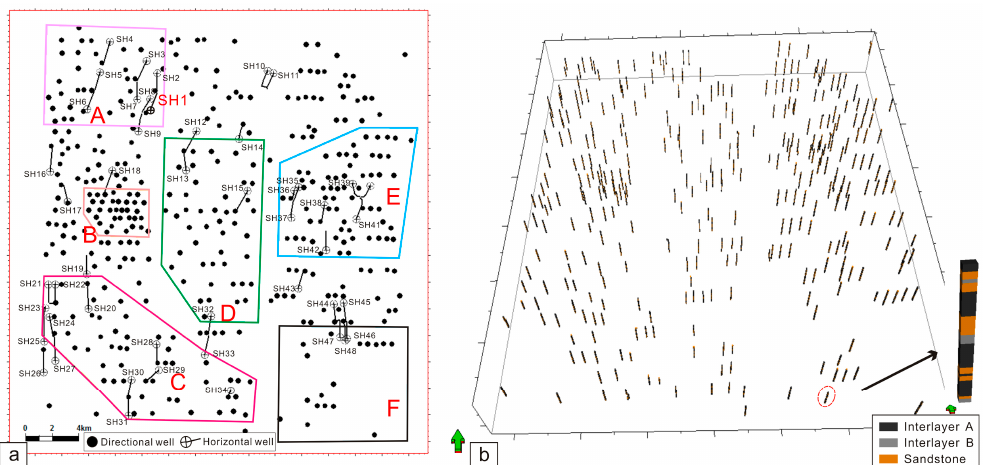
Figure 2. ( a ) Classification of the subdivided zones, showing the locations of directional wells and horizontal wells. While subdividing, the boundaries of the six zones are roughly drawn; ( b ) Discretized sandstone/mudstone data used as input data for stochastic modeling.